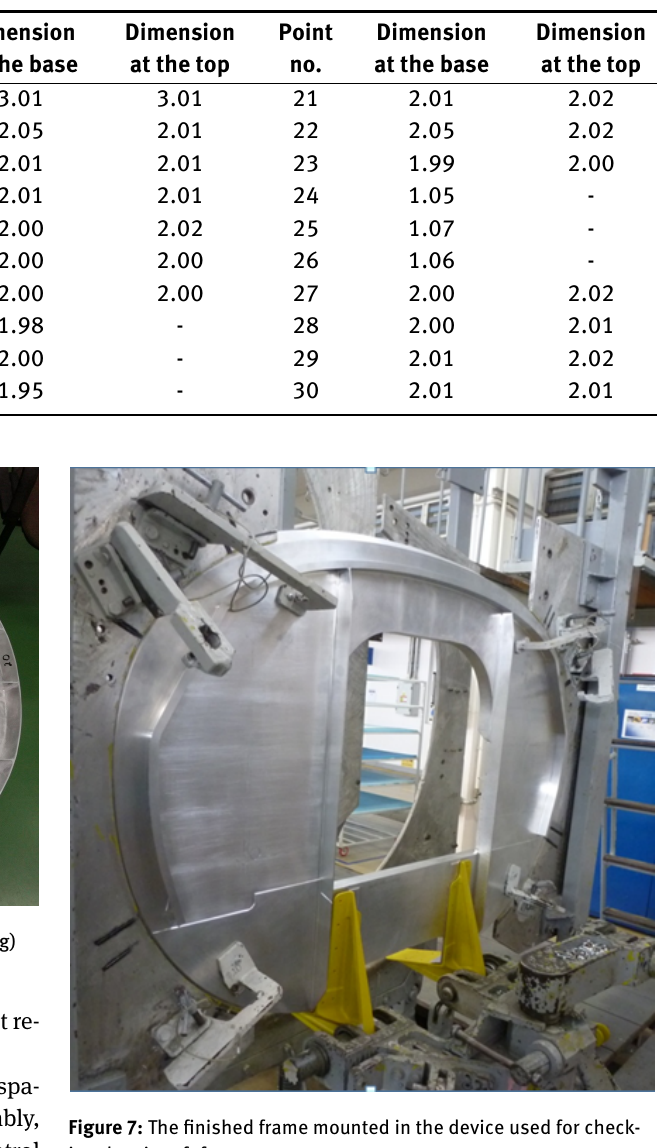
the 7075 aluminium alloys. Appropriate cutting